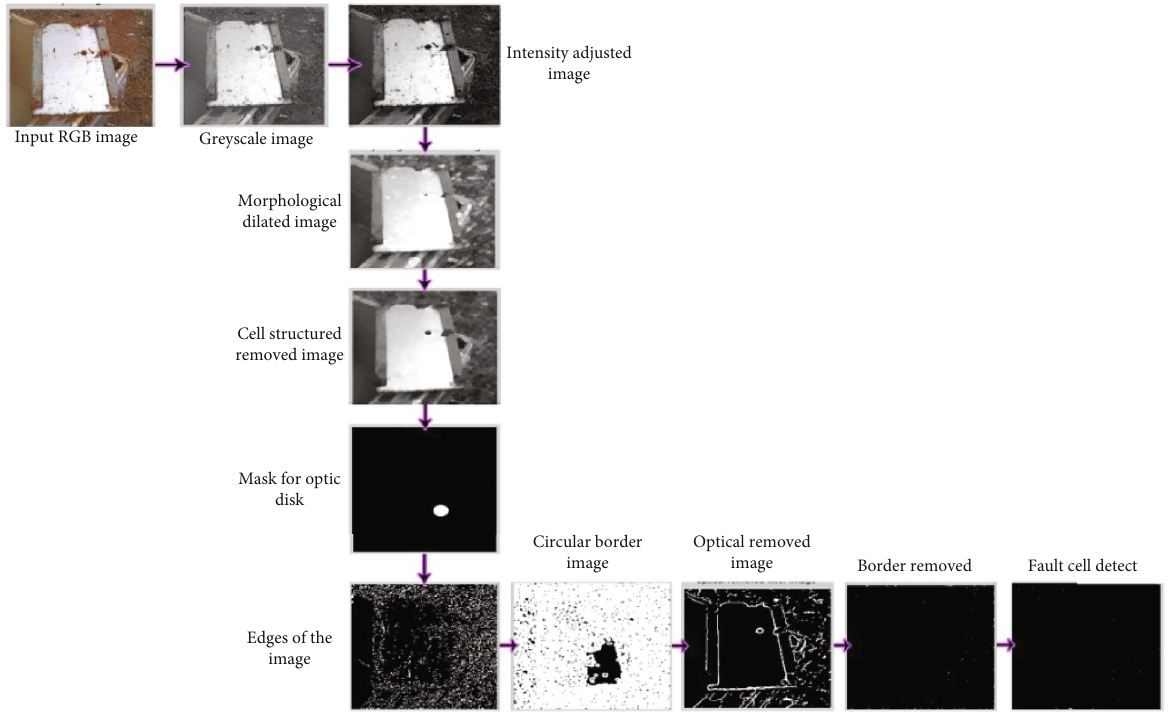
Figure 7: RGB image